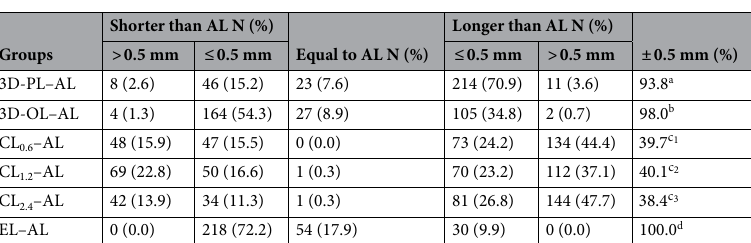
Table 1. The incidence (%) of differences between the four methods and the AL measurements. a,b,c 1,2,3 ,dDifferent superscript letters indicate that there were significant differences at a level of 0.05 ( p a , b = 0.013 ; p a , c 1,2,3 < 0.001 ; p a , d < 0.001 ; p b , c 1,2,3 < 0.001 ; p b , d = 0.030 ; p c 1 , c 2 = < 0.001 ). 3D-PL: Proposed length; 3D-OL: Operator length; 0.739 ; p 0.802 ; p 1.000 ; p c 2 , c 3 = c 1 , c 3 = c 1,2,3 , d